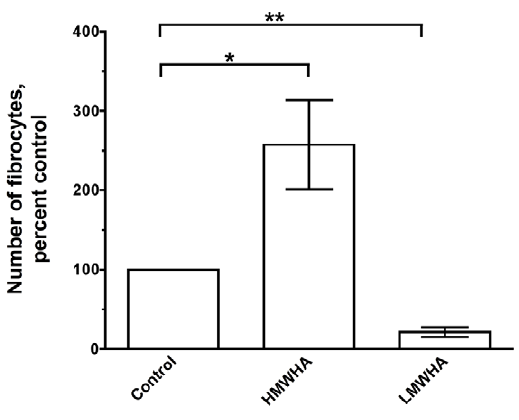
Figure 5. HMWHA potentiates but LMWHA inhibits the differentiation of purified monocytes to fibrocytes. Purified human monocytes were cultured in 300 m g/ml of either HMWHA or LMWHA for 5 days. After 5 days, the cells were air dried, fixed, stained, and the number of fibrocytes was counted. The results are mean 6 SEM of percent no-HA control (n=3 separate experiments). The number of fibrocytes per 2.5 6 10 5 monocytes in controls from the 3 donors was 4250, 2450, and 1600. * indicates p , 0.05 and ** indicates p , 0.01 compared to control as determined by t-test. Using the non-parametric Mann Whitney two-tailed t-test, there is no significant difference among the control, 300 m g/ml HMWHA, or 300 m g/ml LMWHA. Using the non- parametric Mann Whitney one-tailed t-test, 300 m g/ml HMWHA significantly increases the number of fibrocytes when compared to control, 300 m g/ml LMHWA significantly decreases the number of